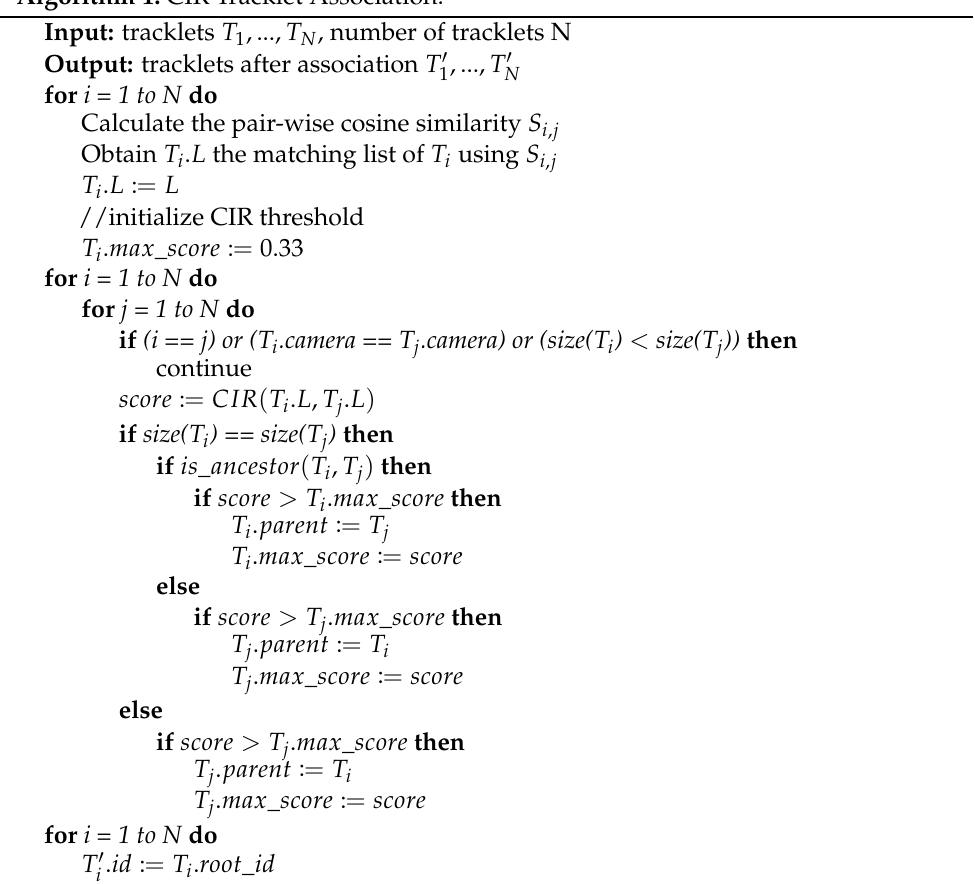
Algorithm 1: CIR Tracklet Association.